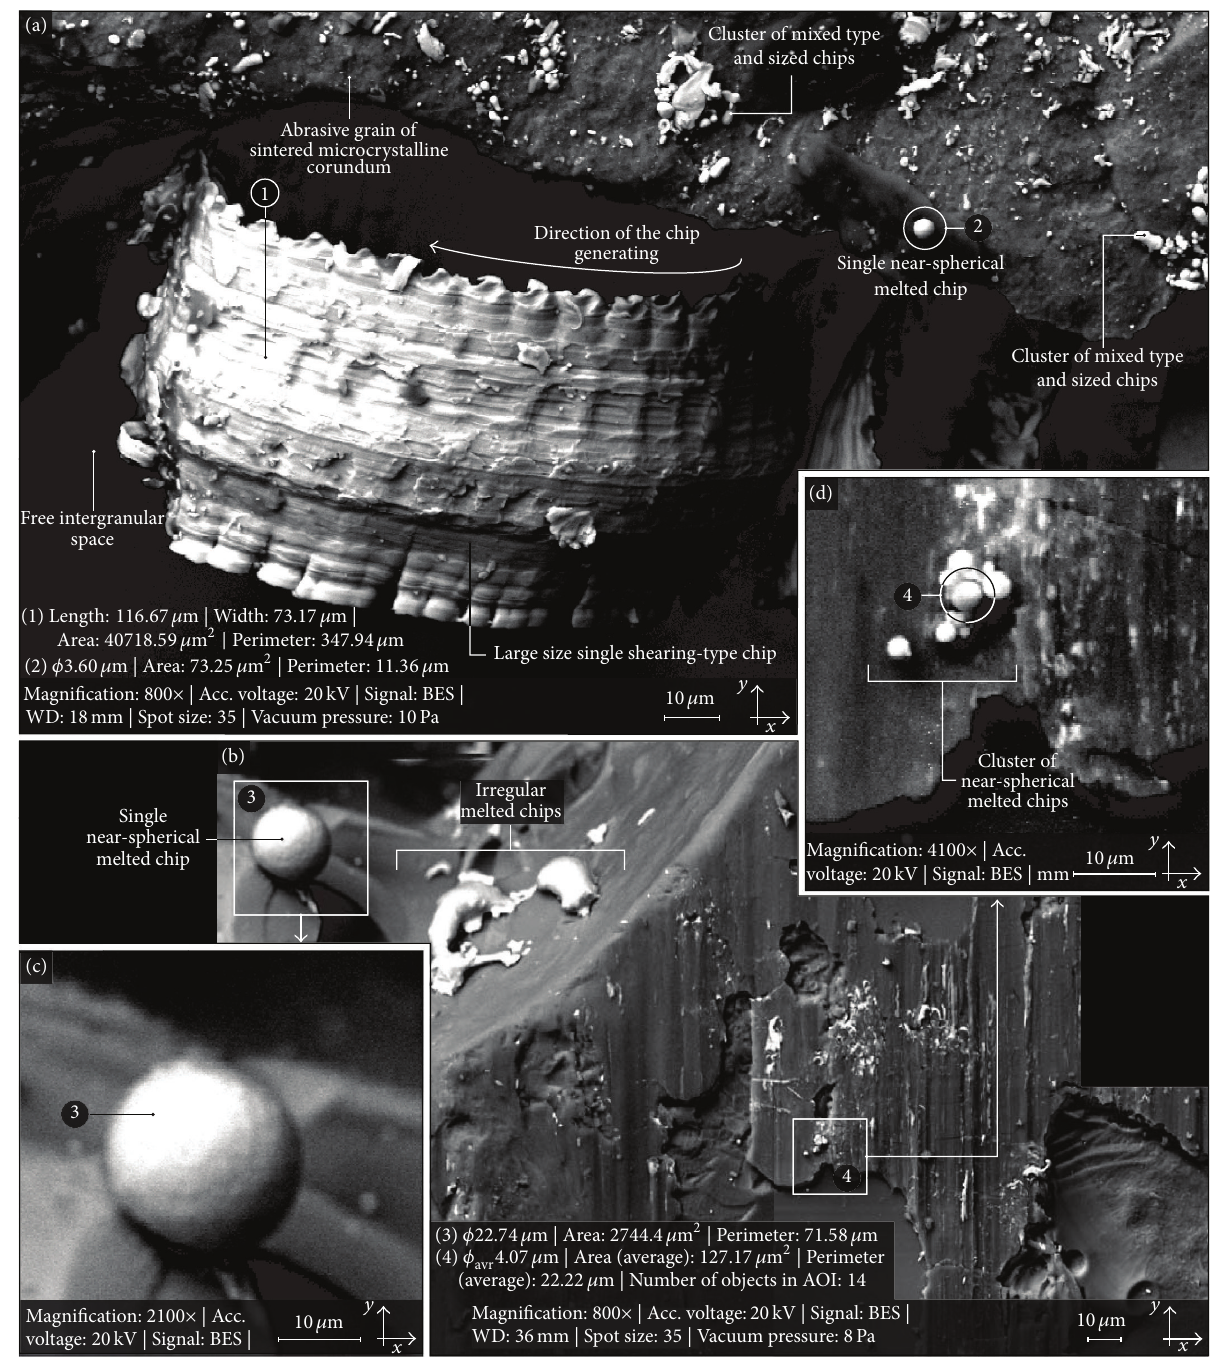
Figure 4: General morphology of single near-spherical melted chips formed after internal cylindrical reciprocal grinding of 100Cr6 steel obtained by use of scanning electron microscope JSM-550LV produced by JEOL: (a) SEM micrograph (size: 209.52 × 128.57 𝜇 m, mag. 800 × ) of GWAS 1–35 × 20 × 10-SG/F46K7VTO, showing size comparison between large size single shearing-type chip and typical single near- spherical melted chip, (b) SEM micrograph (size: 293 × 180 𝜇 m, mag. 500 × ) of GWAS 1–35 × 20 × 10-SG/F46K7VTO, showing the situation, when, on this same GWAS, single near-spherical melted chip and cluster of near-spherical melted chips were formed, (c) AOI (size: 48.38 × 48.38 𝜇 m, mag. 2100 × ) extracted from (b) with single near-spherical melted chip, and (d) AOI (size: 48.38 × 48.38 𝜇 m, mag. 4200 × ) extracted from (b) with cluster of near-spherical melted chips. Note: Acc. voltage, accelerating voltage; BES, backscattered electron (shadow image); WD, working